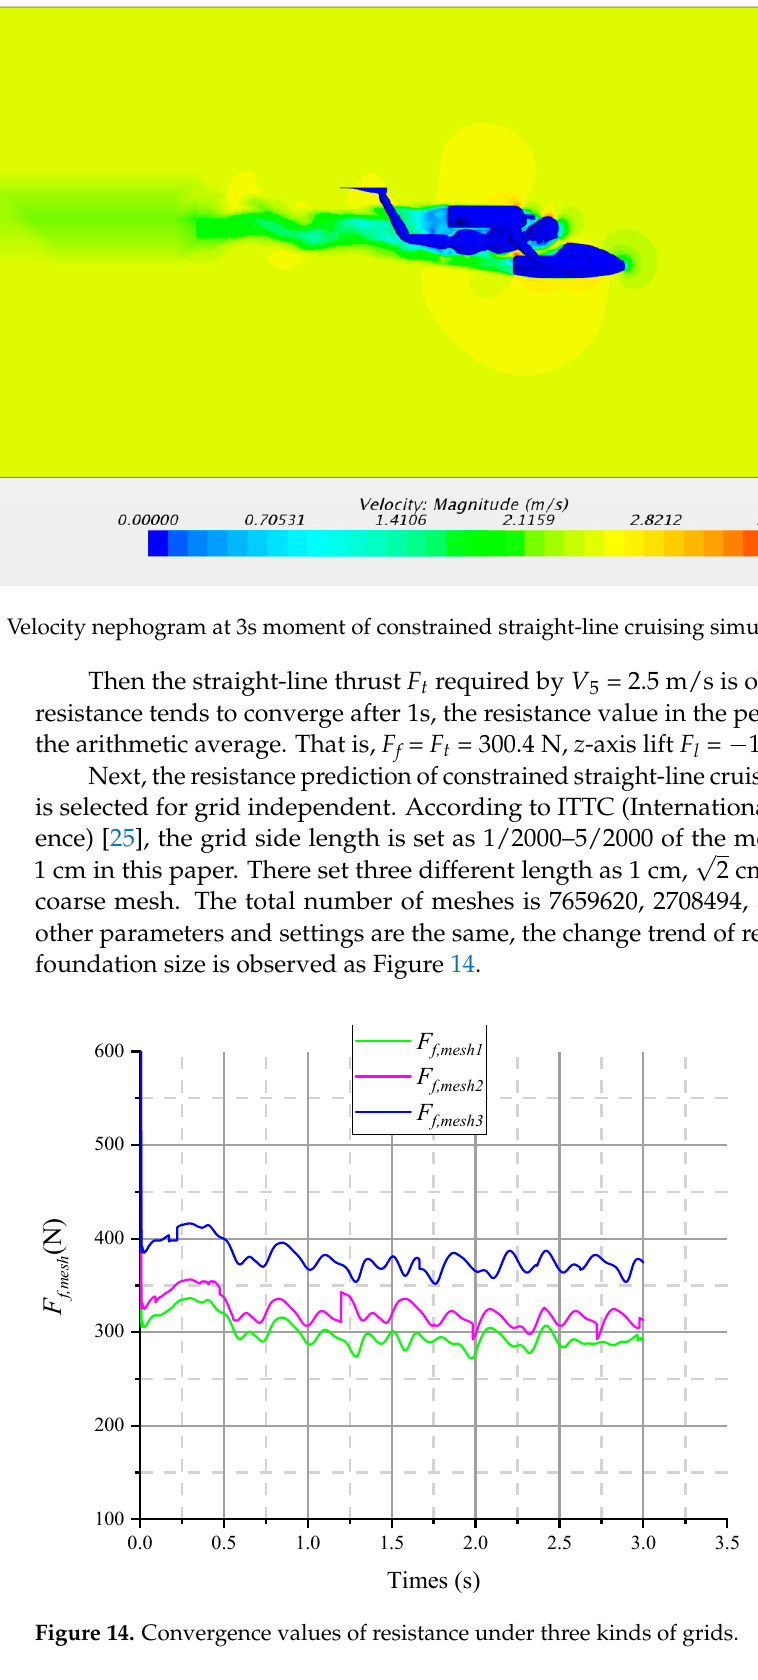
Figure 12. Resistance convergence results of constrained straight-line cruising simulation.